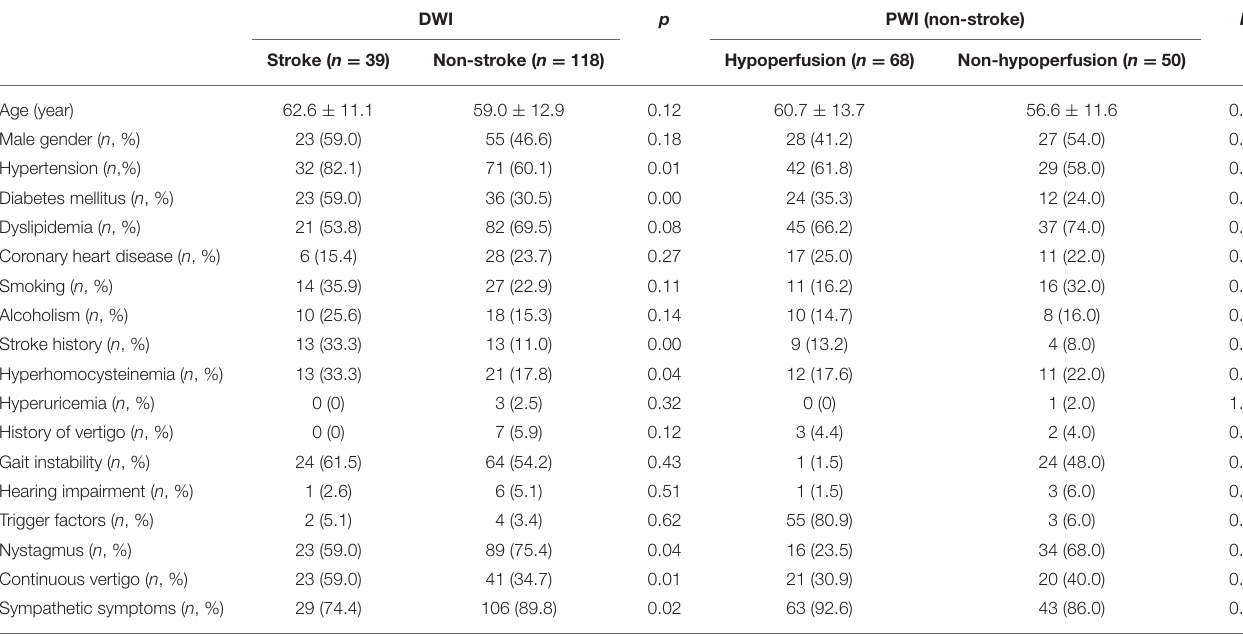
TABLE 2 | Cerebrovascular risk factors and clinical characteristics stroke and